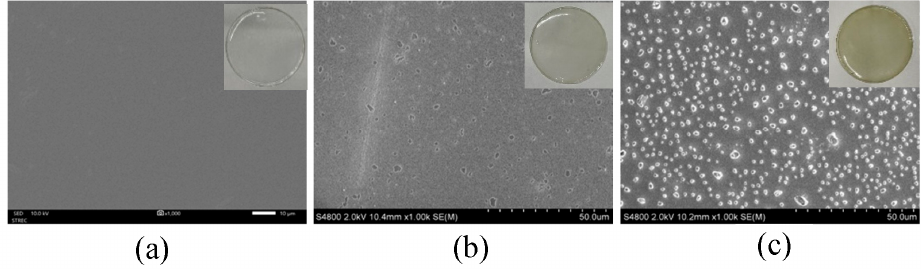
Figure 10. SEM image of cast PVA film: ( a ) pure PVA, ( b ) PVA/CuI (0.095%) and ( c ) PVA/CuI (0.190%).